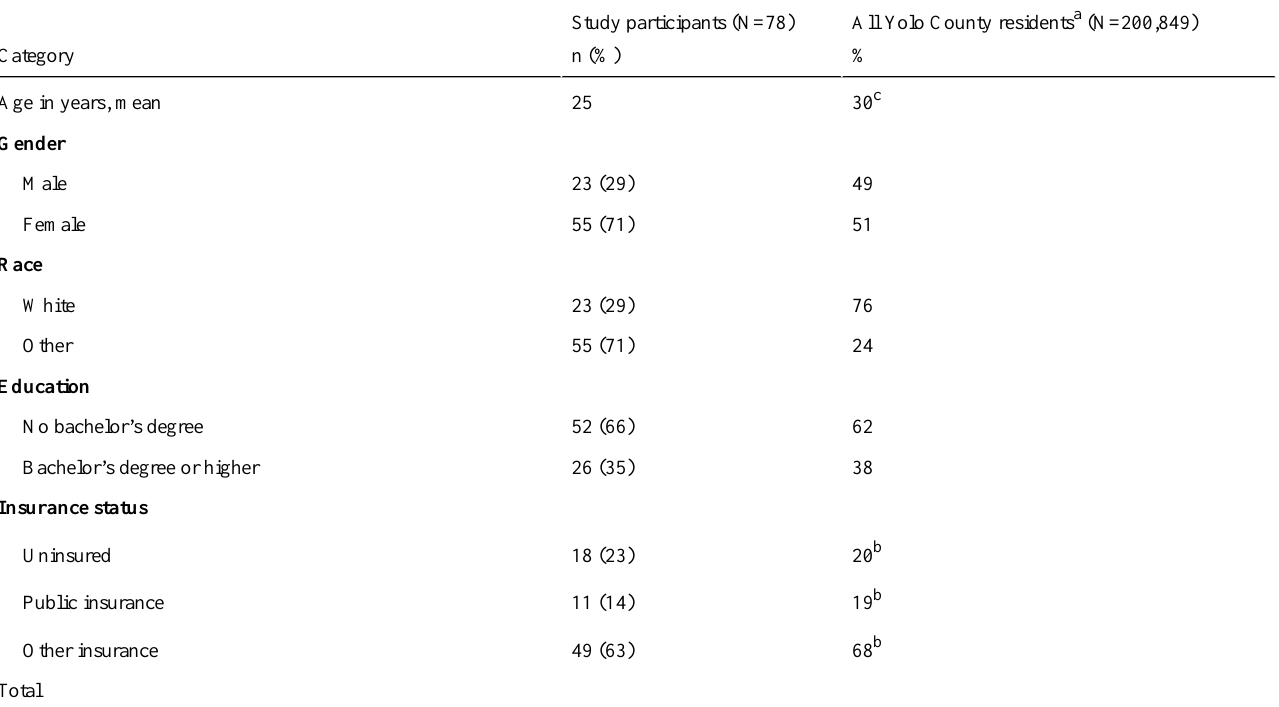
Table 1. Summary of participant demographic